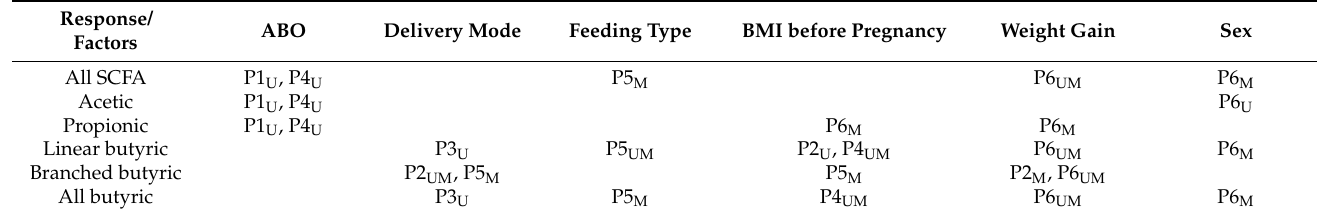
Table 10. Summary of the multivariable and univariable analyses of